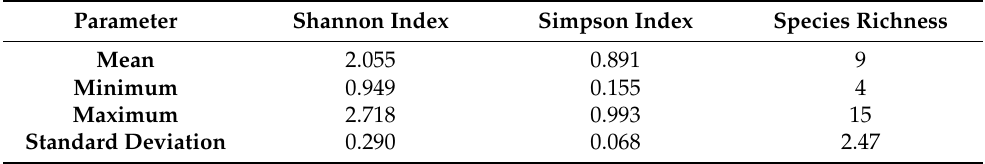
Table 2. Descriptive statistics of Shannon Index (H (cid:48) ), Simpson Index (D 1 ) and Species richness (S) produced from the field inventory